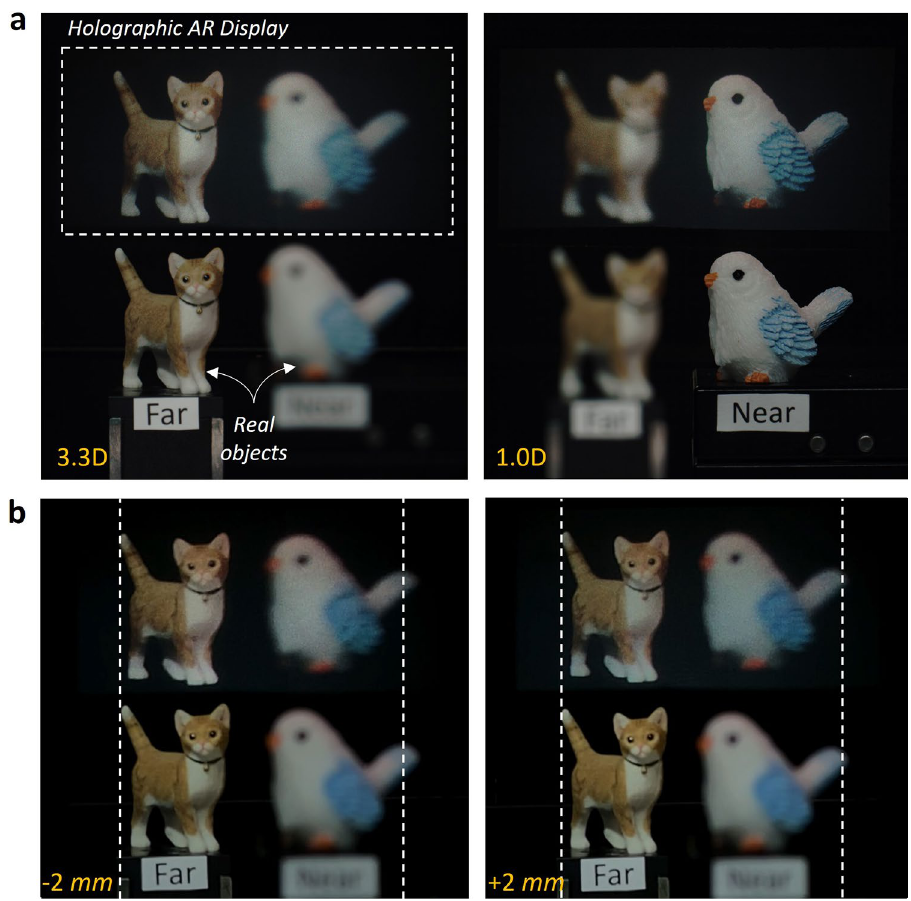
Figure 5. AR demonstration of true 3D holography featuring realistic focus cues and parallax The real objects are placed on the 3.3D (bird) and 1.0D (cat). ( a ) Focal sweep results of our AR prototype, where the hologram shows realistic focus cues that of the real object. ( b ) Parallax results by laterally shifting the camera. Bottom insets are the shifted distance of the camera, and dot lines indicate the identical FOV in both results. The hologram and real objects are captured